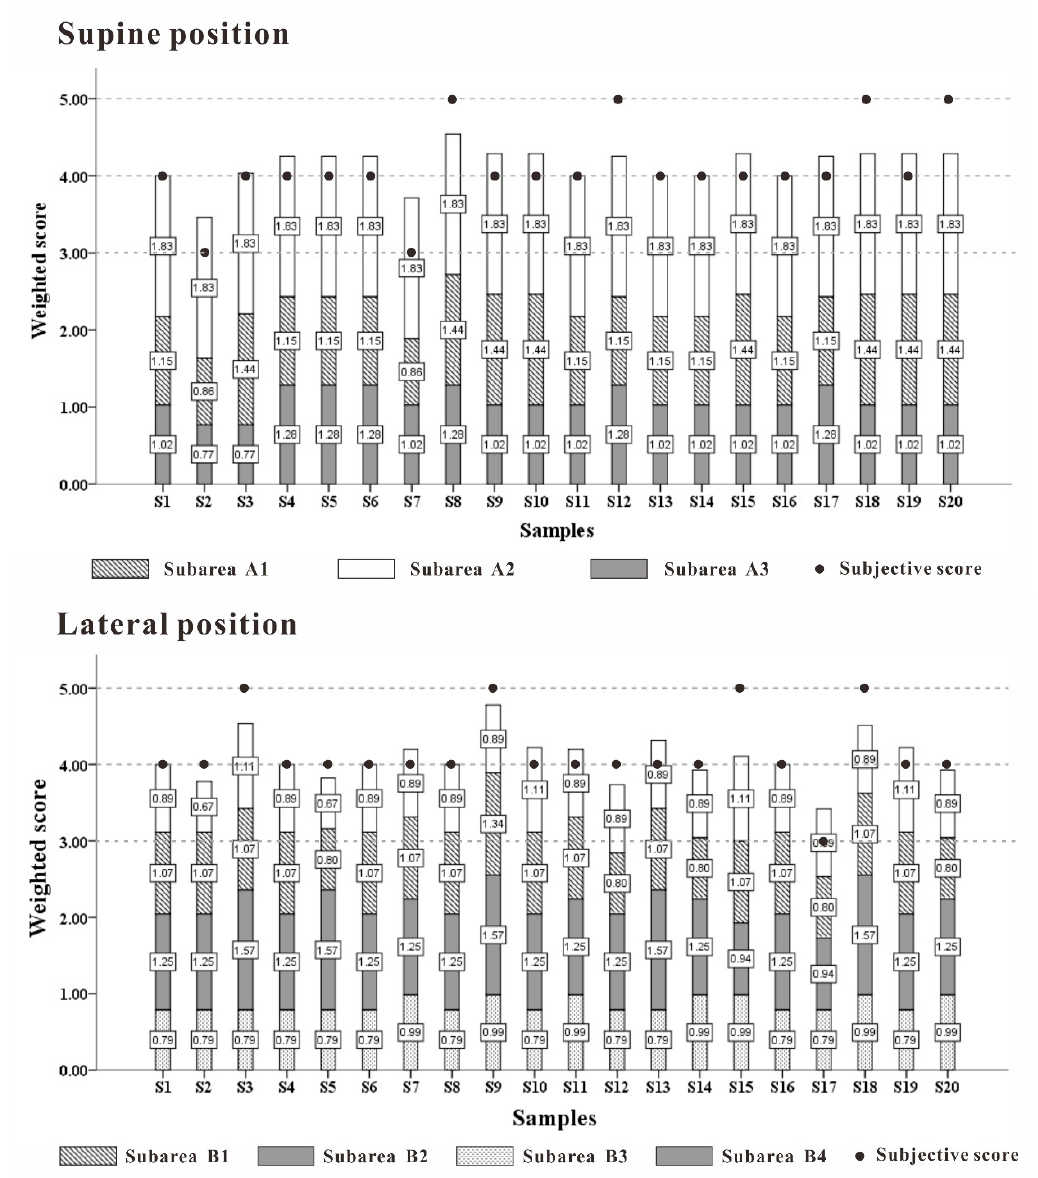
Figure 15. Comparison of weighted comprehensive evaluation of each recumbent